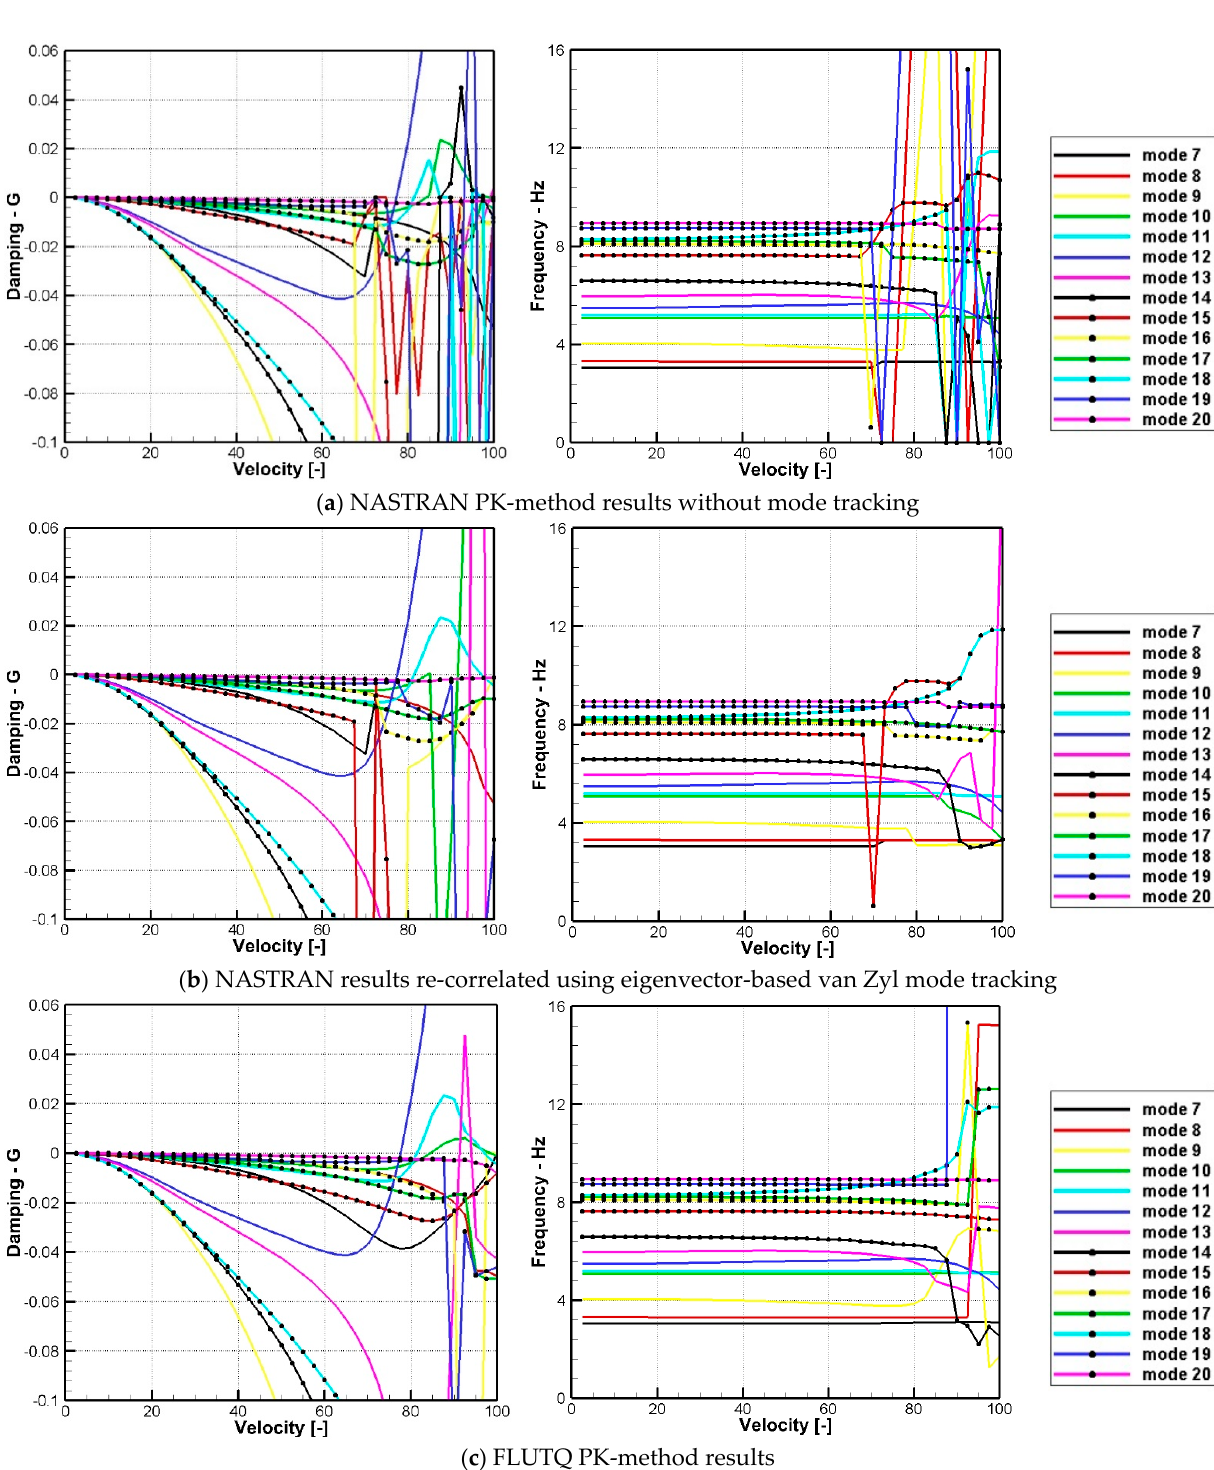
Figure 7. Effectiveness of mode tracking: damping and frequency diagrams for the Symmetric 1 configuration of the real-world jet aircraft with velocities arbitrarily normalized.